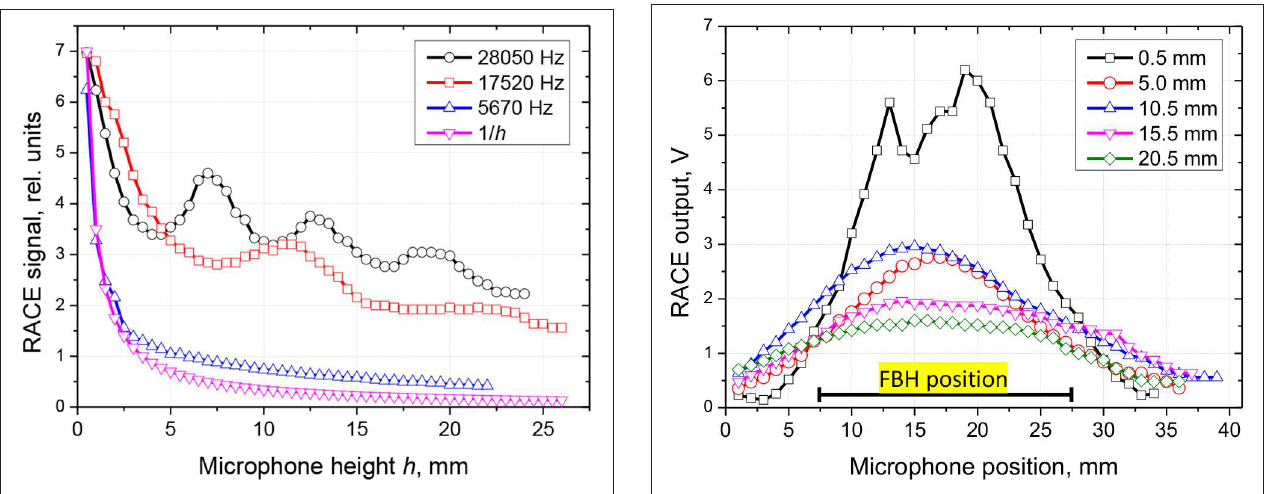
FIGURE 3 | RACE scans along the diameter of FBH at different vertical